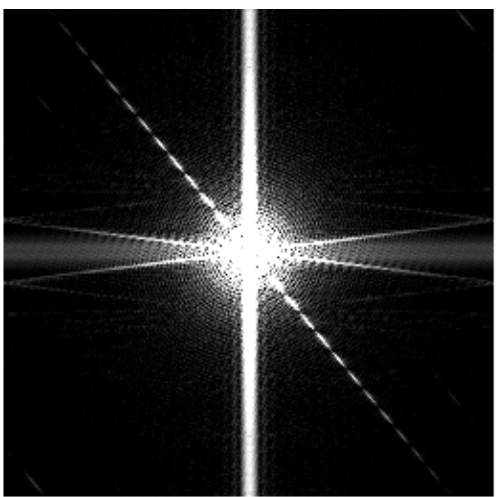
Figure 8. The amplitude of the 2D QFT for the 110th projection, i.e., projection angle 77 degrees. The whole procedure includes the following